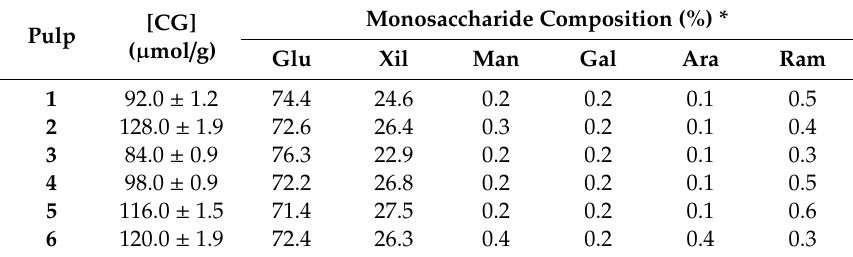
Table 1. Carboxylic groups content (CG) and monosaccharide composition of pulps. Pulp